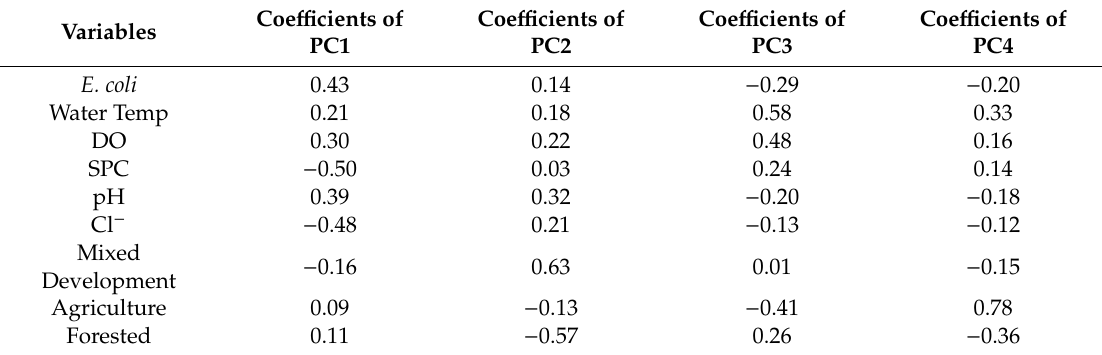
Table A10. Coe ffi cients of annual principal components comprising 9 variables ( E. coli concentration, water temperature, DO, SPC, pH, chloride, percentage of mixed developed land use, percentage of agricultural land use and percentage of forested land use) used to define 9 principal components during